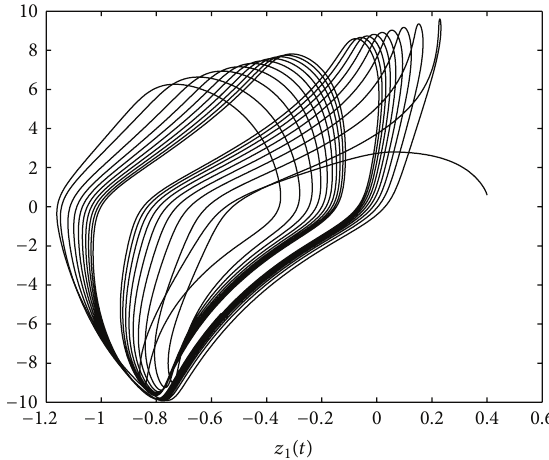
Figure 6: Chaotic trajectory of